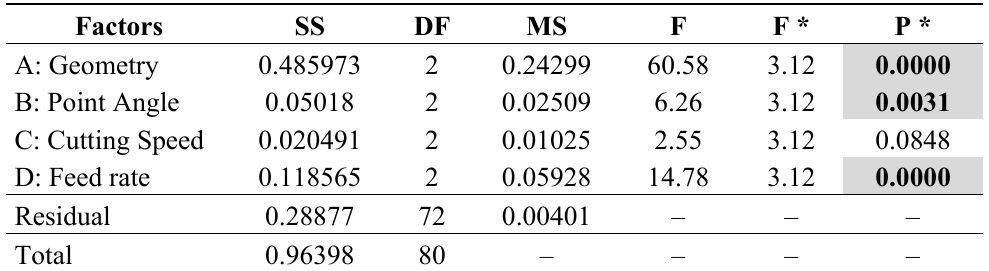
Table 4. ANOVA results for entry delamination